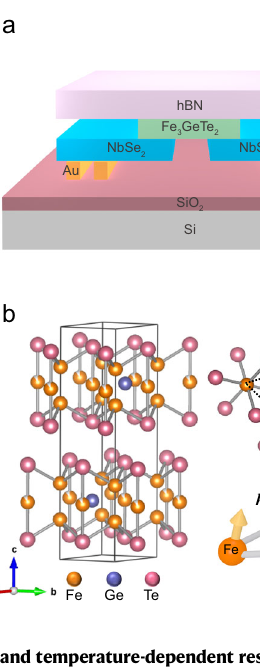
transitions are identi fi ed, with the fi rst two T c1 =6.9K from superconducting NbSe 2 , and T c2 ~5.4K from the proximity-induced superconducting transition of the S/F bilayers at each end of the S/F/S. The red solid line represents the BKT transition using the Halperin – Nelson equation for fi tting, which gives the third transition with a BKT temperature T BKT =3.7K. Source data are provided as a Source Data fi